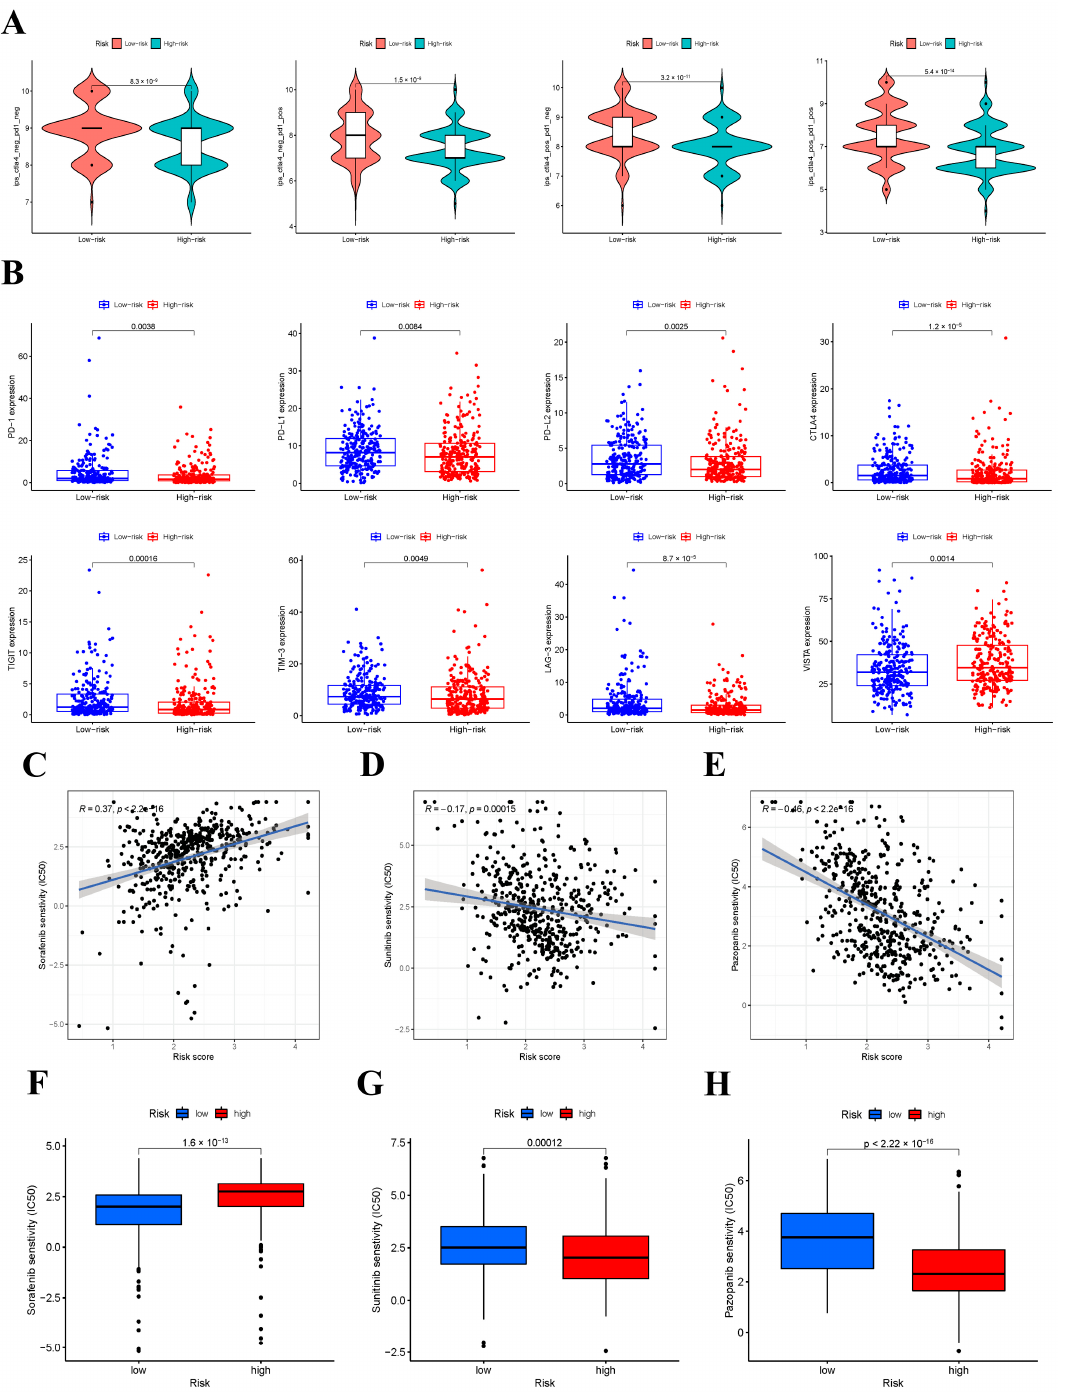
Figure 7. IPS analysis and the role of the prognostic risk score in targeted therapy. ( A ) The association between IPS and the immune − related prognostic signature. ( B ) The expression of PD − 1, PD − L1, PD − L2, CTLA4, TIGIT, TIM − 3, LAG − 3, and VISTA in low − and high − risk groups. ( C – E ) The corre- lation between risk scores and estimated IC50 value of sorafenib ( C ), sunitinib ( D ), and pazopanib ( E ). ( F – H ) Comparison of estimated IC50 value of sorafenib ( F ), sunitinib ( G ), and pazopanib ( H ) between low − and high − risk score